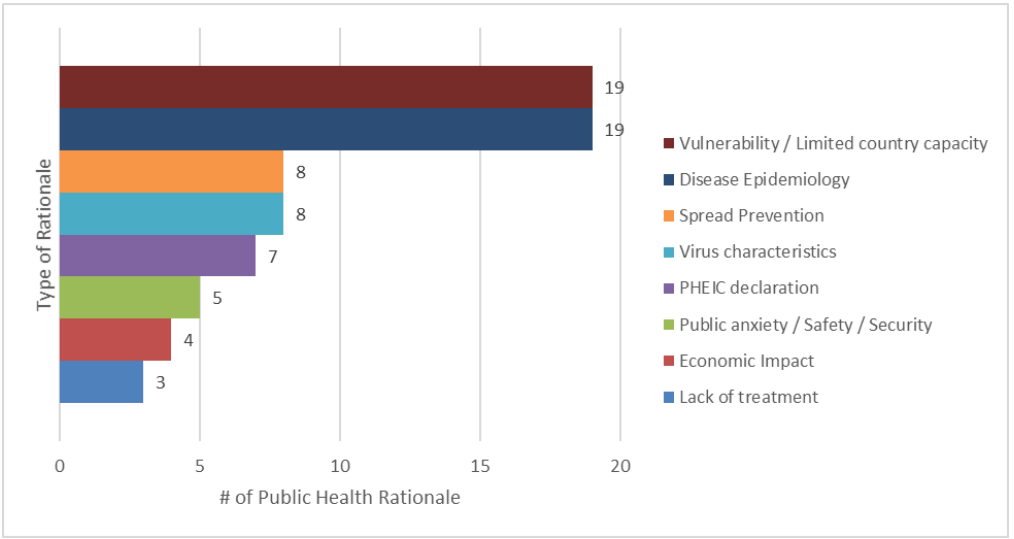
Figure 2. Number and types of public health rationale for implementing additional health